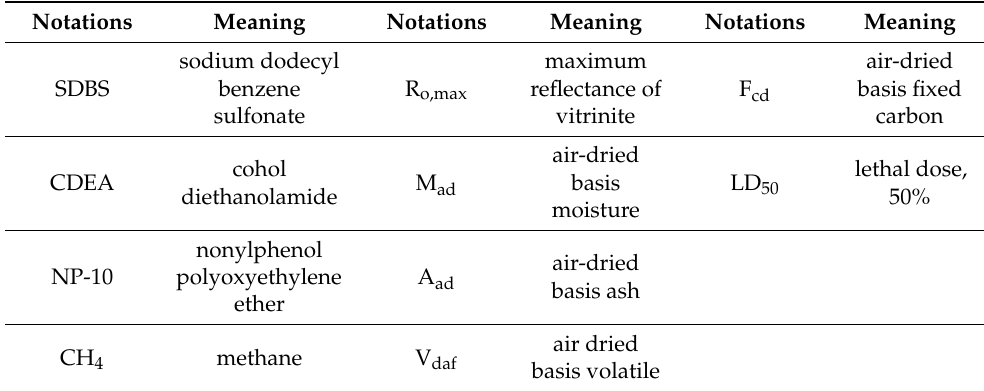
Table 3. Abbreviations and